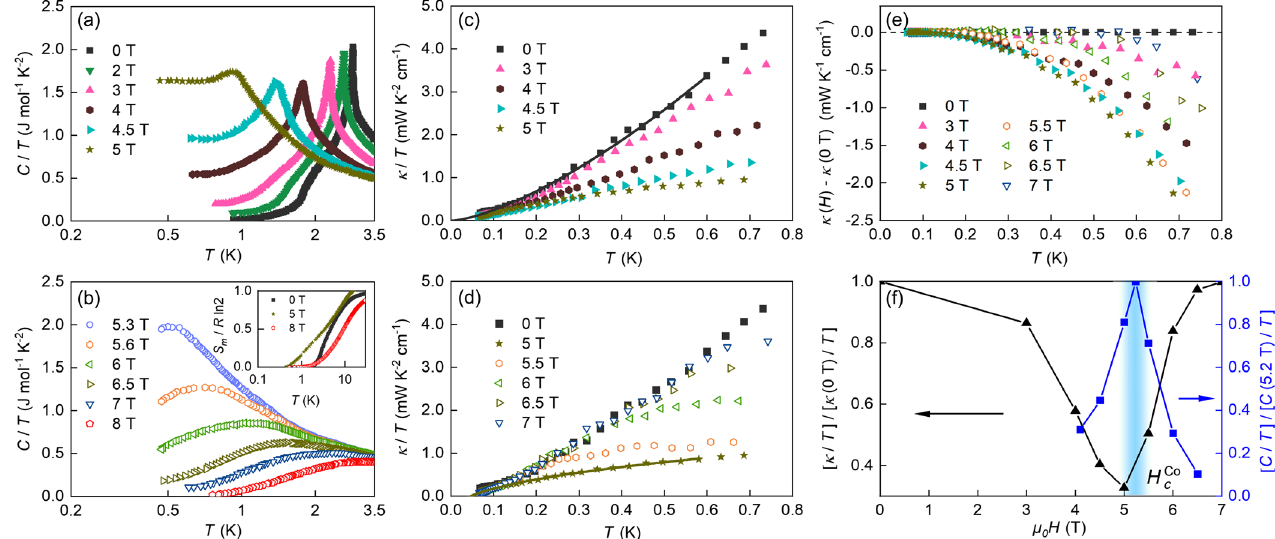
∼ 5 . 24 T, respectively. The inset of (b) shows the magnetic c κ =T ¼ a þ bT α − 1 . c